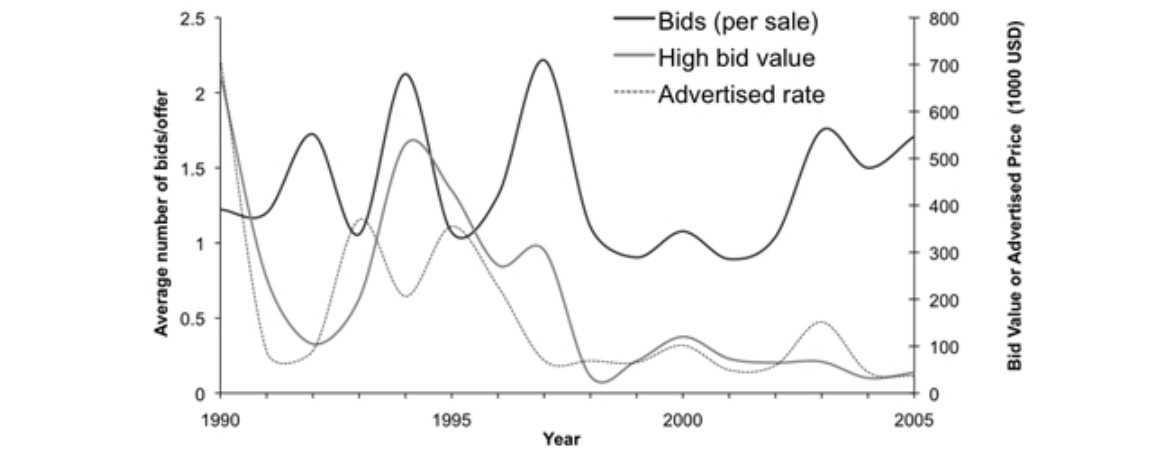
Fig. 3 . Tongass National Forest timber sale bids, average winning bid values and mean advertised rate of sale offers, from 1990-2005. The left axis is the average number of bids per sale, per year. The right axis is the average winning bid value or the average advertised price, in USD (not adjusted for